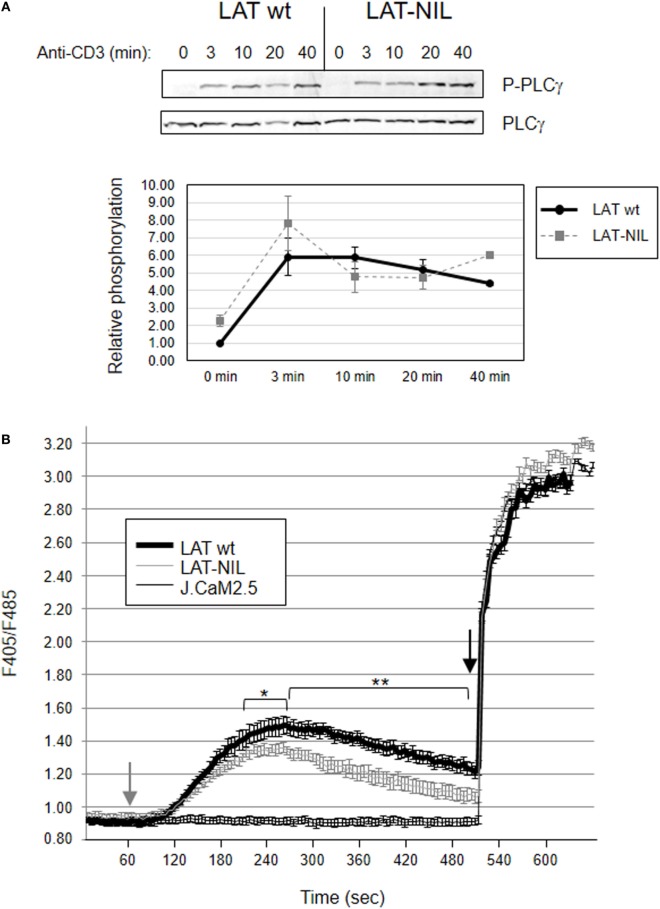
Activation of PLC-γ and Ca2+ influx generation. (A) JCaM2 cells expressing WT-linker for activation of T cell (LAT) or the LAT-NIL mutant were stimulated at 37°C with anti-CD3 antibody for the indicated times, and whole-cell lysates were probed by Western blotting for the activation of PLC-γ1 by using a mAb recognizing PLC-γ1 phosphorylated on tyrosine 783 (upper panel). Stripped membranes were blotted with anti-PLC-γ1 mAb to show equal protein expression (middle panel). Densitometric quantification of six independent experiments is shown in the lower diagram, representing mean fold increase in PLC-γ1 phosphorylation for J.CaM2 cells expressing WT-LAT (thick continuous line) or the LAT-NIL mutant (thin dashed line). (B) Untransduced J.CaM2 cells or J.CaM2 cells expressing WT-LAT or the LAT-NIL mutant were loaded with Indo-1AM and stimulated with OKT3 mAb (1 µg/ml) at the indicated time (grey arrow). The intracellular Ca2+ concentration was determined at 37°C through the change in Indo-1AM fluorescence. The charge of Indo-1AM dye was assessed by observing the response to stimulation with ionomycin (1 μM, black arrow). Bars represent the standard error. Asterisks represent statistical significance.